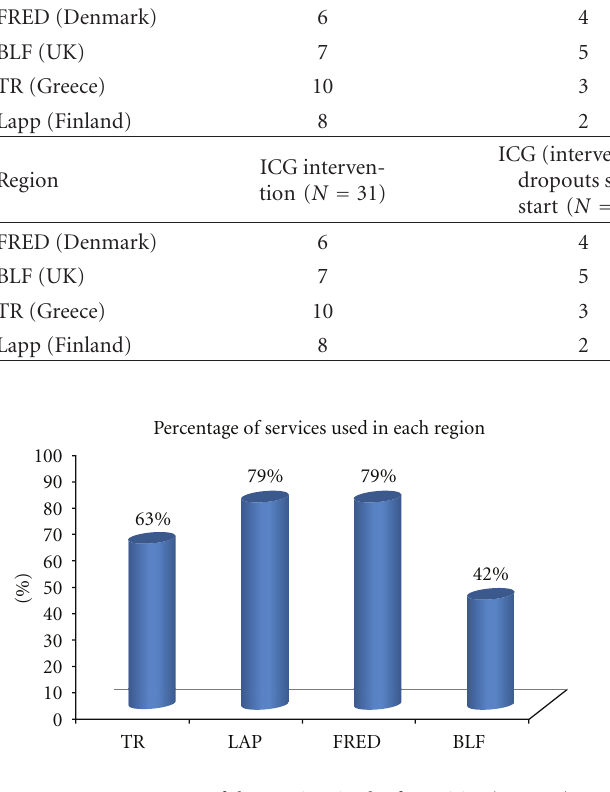
Figure 2: Average use of the services in the four cities ( N =